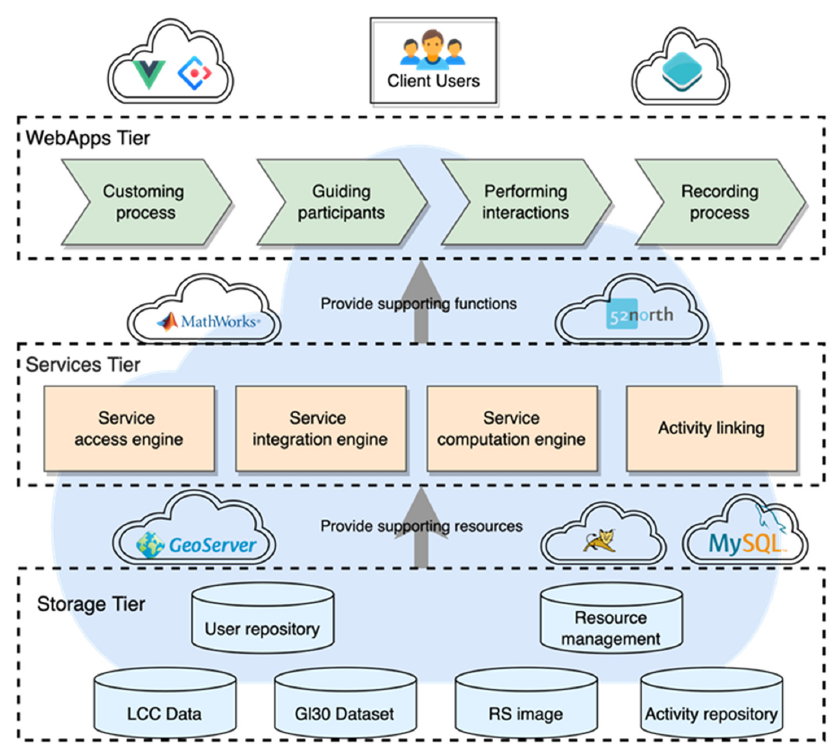
Figure 5. System